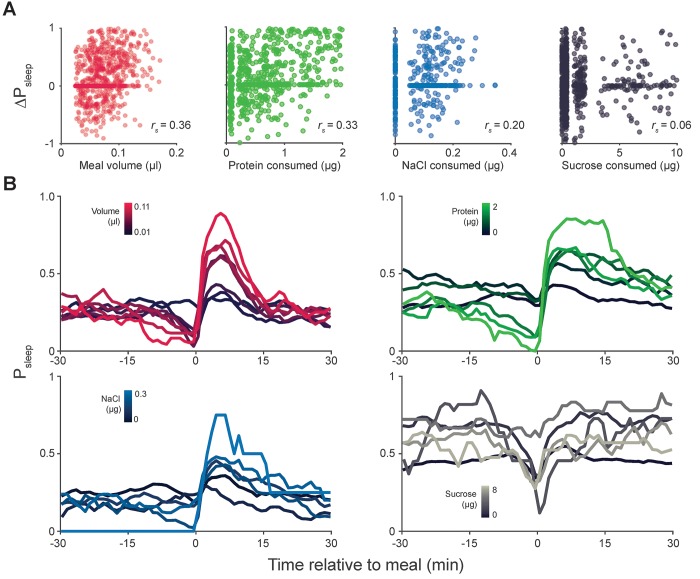
Meal component correlates to postprandial sleep.(A) Scatter plots representing individual meals showing 20 min ΔPsleep versus meal volume or consumed protein, salt (NaCl), or sucrose. Non-normal data in each plot can arise from the tendency for fully awake animals to stay awake (ΔPsleep = 0) and from low variation in nutrient consumption within animals given a low nutrient, fixed diet (protein, NaCl, or sucrose consumption = 0 µg). Spearman rank-order correlation: p=1.52 × 10−25, volume; p=1.73 × 10−19, protein; p=6.84 × 10−6, NaCl; p=0.055, sucrose). (B) Time-courses of sleep probability for component groupings (lines represent mean for each grouping).